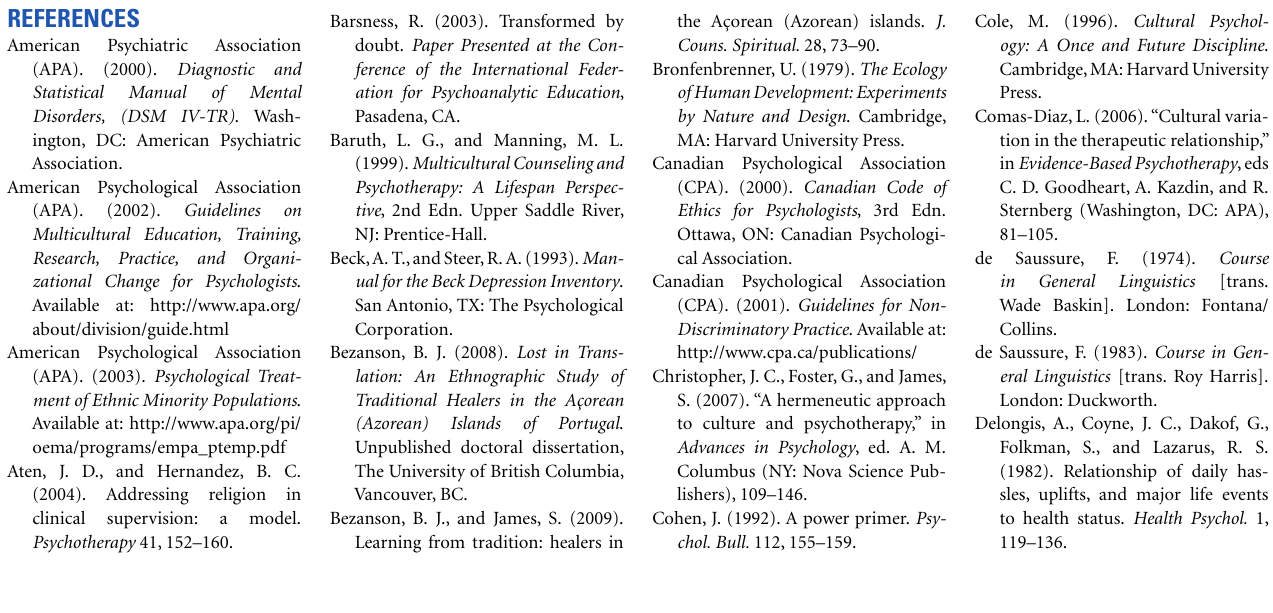
Table 2 outlines a set of questions that are informed by ethno- graphic research methods. Our model focuses on understanding the person in a multicontextual way and utilizes the four contexts or domains discussed above: individual, familial, socio-cultural, and religio-moral (see Figure1 ). By exploring each level we under- stand the person in a multicontextual way with the understanding that all levels are interrelated and